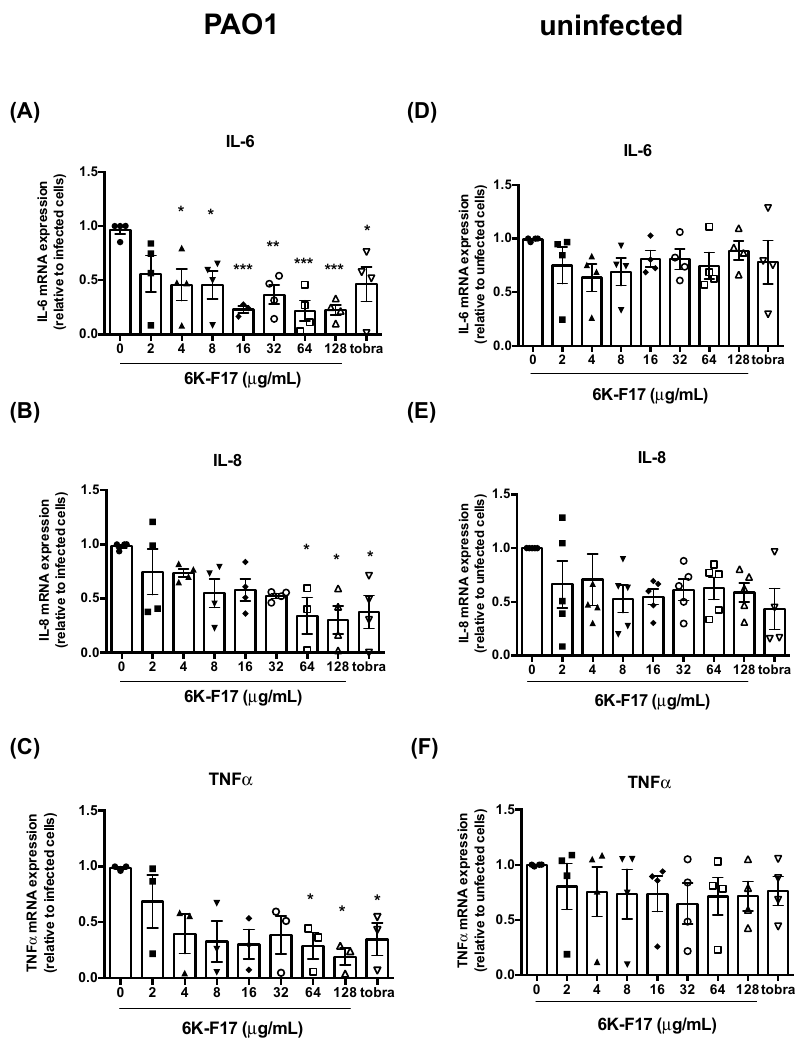
Figure 4. Inflammatory response to PAO1 infection is suppressed by 6K-F17 pre-treatment in human bronchial epithelial cells. ( A – C ) F508del-CFTR HBE cells were incubated with PAO1 +/ − 6K-F17 or 10 µg/mL Tobramycin (Tobra) for 4 h at 37 °C. ( D – F ) F508del-CFTR HBE cells were incubated with 6K-F17 or 10 µg/mL Tobramycin (Tobra) for 4 h at 37 °C. Total RNA was extracted and qRT-PCR was performed in order to quantify IL-6, IL-8 and TNF α mRNAs. Data represent the mean ± SEM (* p < 0.05, ** p < 0.01, *** p < 0.001; n ≥ 4; each dot represents one biological replicate). The treatment of F508del-CFTR cells with VX-809 does not decrease infection rate and does not potentiate 6K-F17 anti-infective activity . HBE cells were pre-incubated with VX-809 for 24 h prior to PAO1 infection and treatment with 6K-F17 or tobramycin to assess the impact of the corrector VX-809 on the infection rate and on F508del-CFTR function. The presence of the corrector VX-809